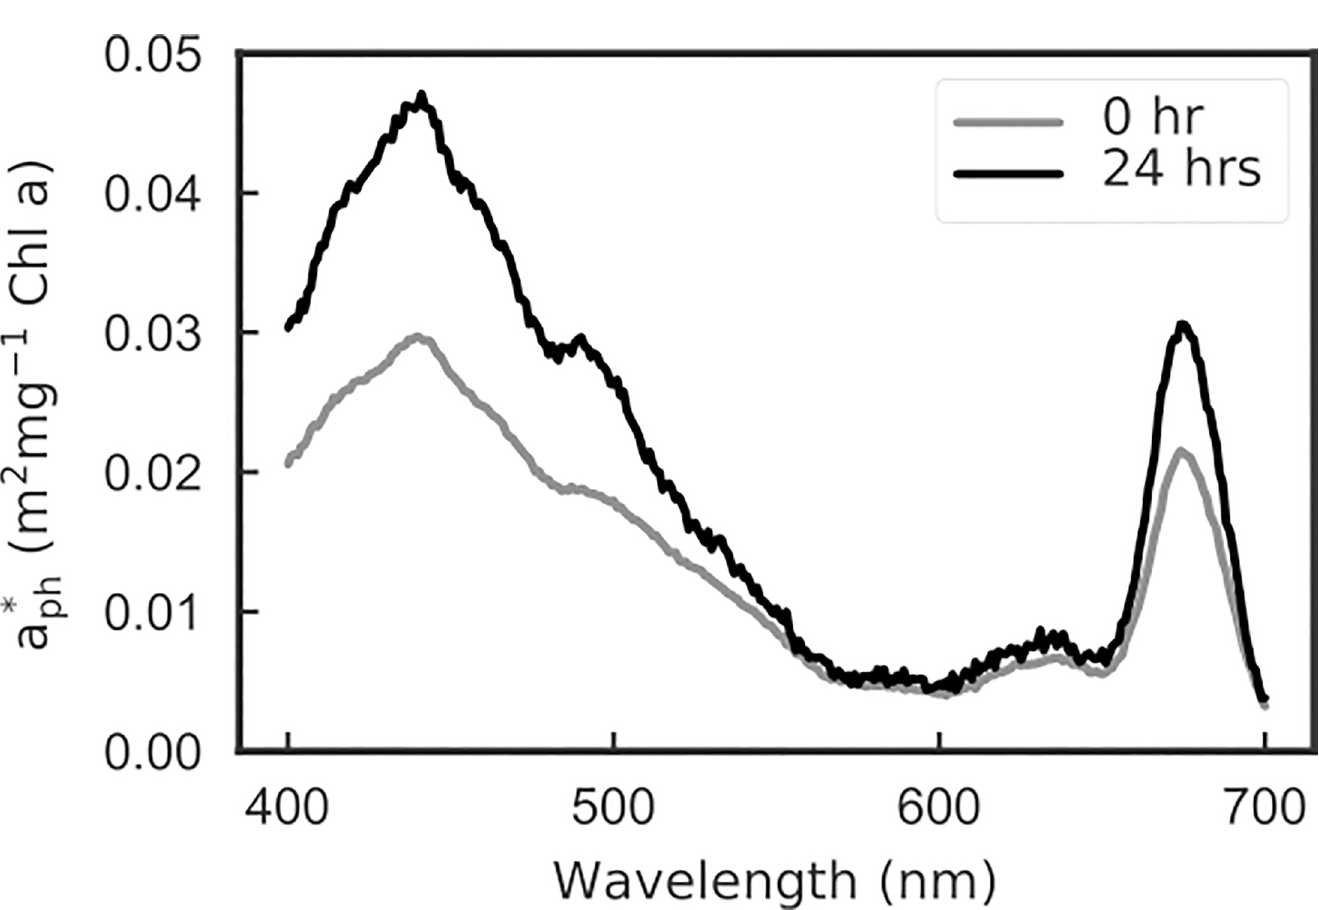
Fig 7. Spectral chlorophyll a specific absorption coefficients measured at 0 and 24 hours during the 24 hours low-to-high light acclimation.